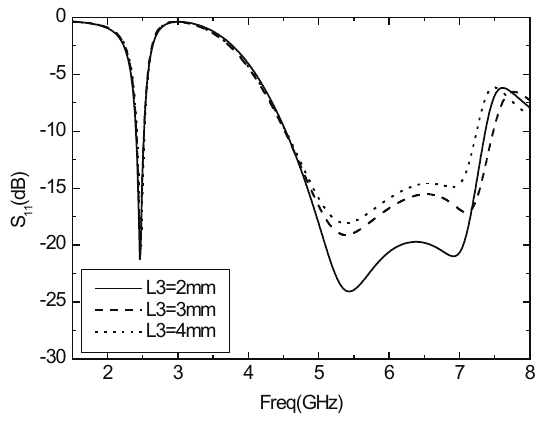
Figure 5. Parameter S 11 varies with L3.